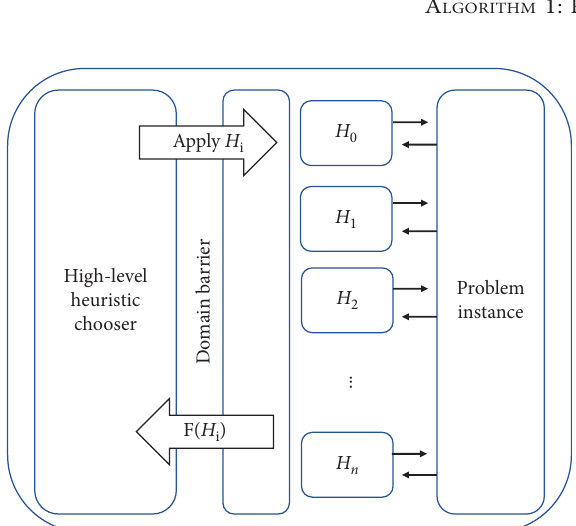
Figure 1: General framework of a selection hyper-heuristic based on